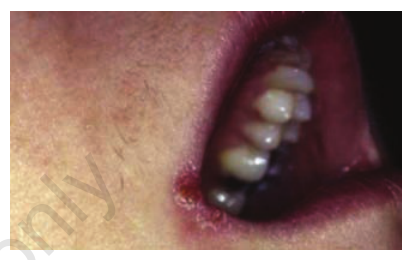
Figure 3. Angular cheilitis. 8 Reproduced with permission from IAS-USA. Top HIV Med